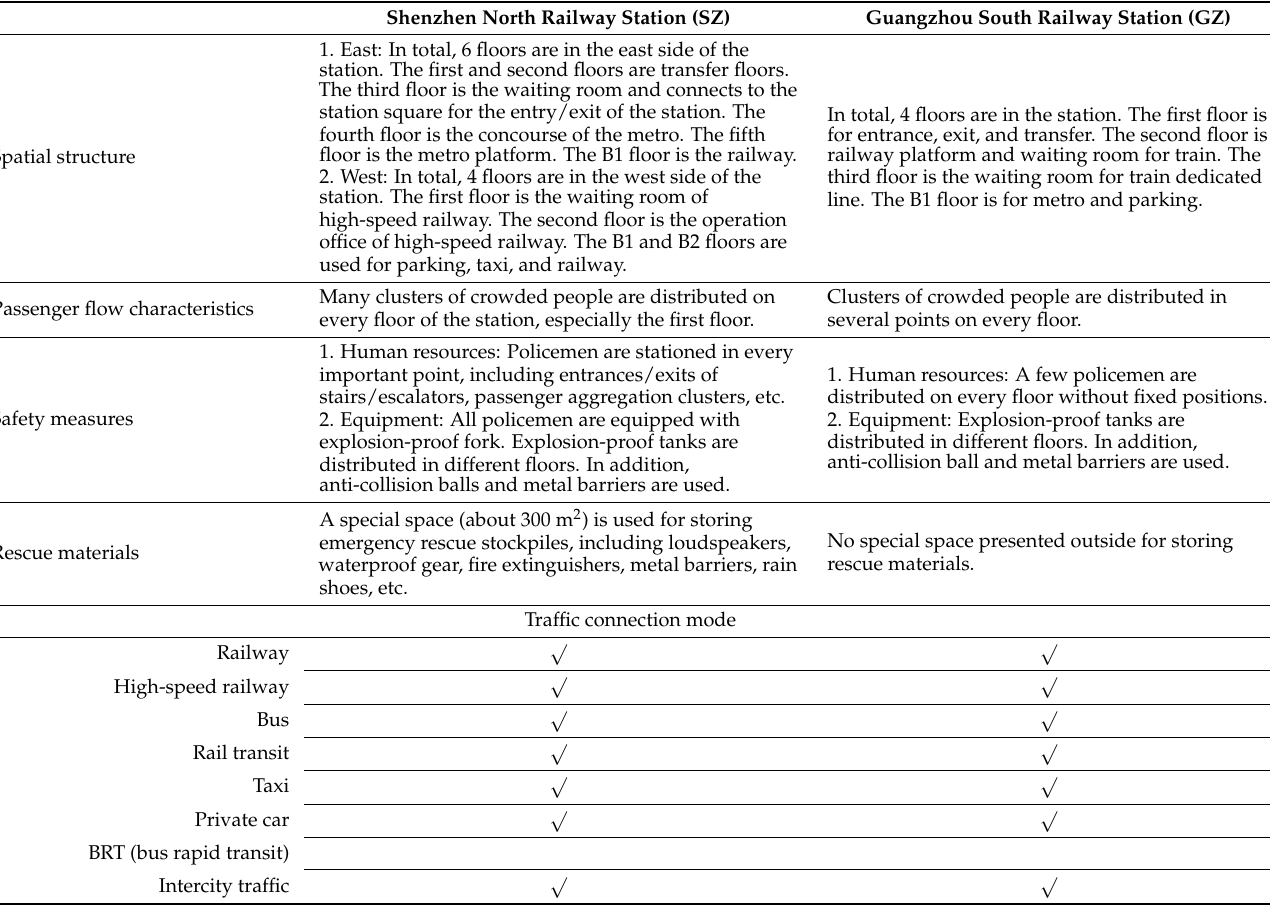
Table 1. Characteristics of SZ and